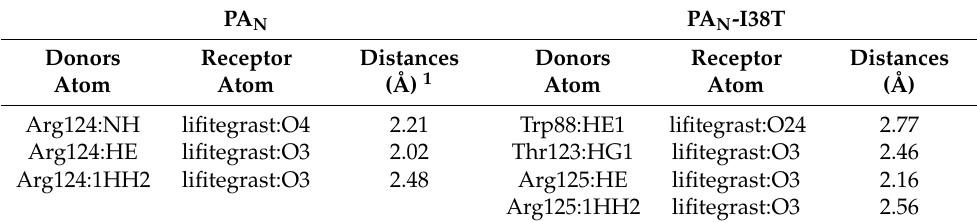
Figure 5. The interaction of lifitegrast within PA N and PA N -I38T active sites. The representative structure is extracted from the largest number of clusters in the system after molecular dynamics simulation. Electrostatic potential surface of PA N ( A ) or PA N -I38T ( B ) structure with lifitegrast in the active site pocket. Structure of PA N ( C ) or PA N -I38T ( D ) with lifitegrast. Manganese ions are indicated as gray spheres. Lifitegrast is shown using blue sticks. PA N or PA N -I38T are shown as green cartoons. Hydrogen bonds are shown as yellow dashed lines. Table 2. Hydrogen bond parameters of lifitegrast and PA N /PA N